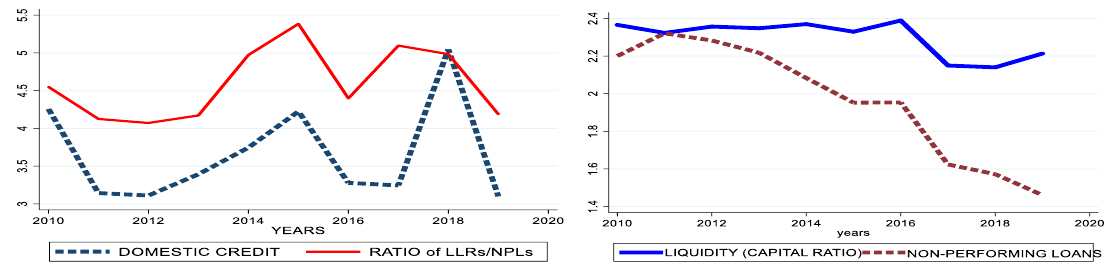
Figure 11: Ratio of llr/Npls & Credit Growth Trends. Figure12: Scissors Movements: Npls vs. Bank Liquidity Ratio Figure 11: This figure presents the cointegration movement between the ratio and loan loss reserves to non-performing loans and the